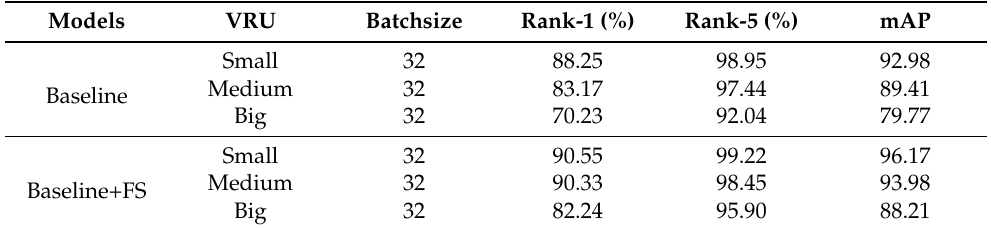
Table A5. Test results of the baseline model and the full-scale model with input batch 32 on the VRU dataset.